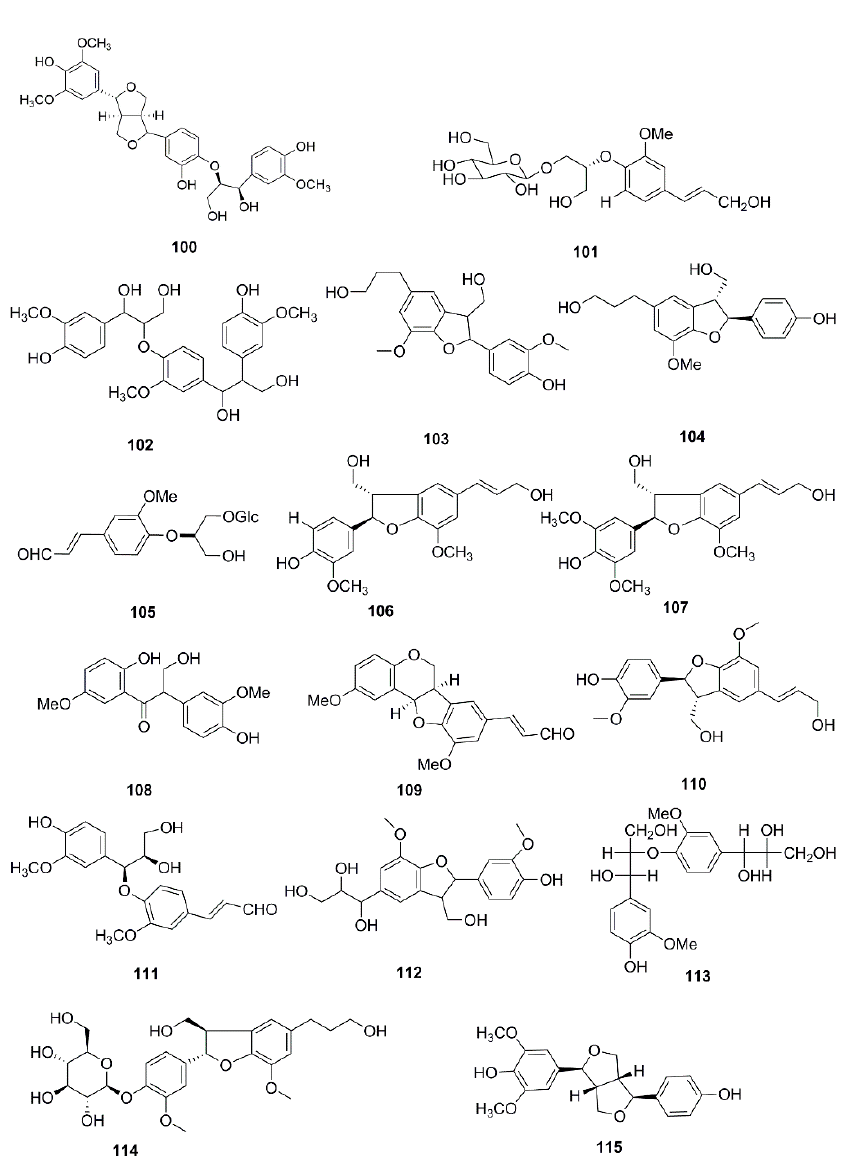
Figure 5. Chemical structures of the lignanoids in X. strumarium.